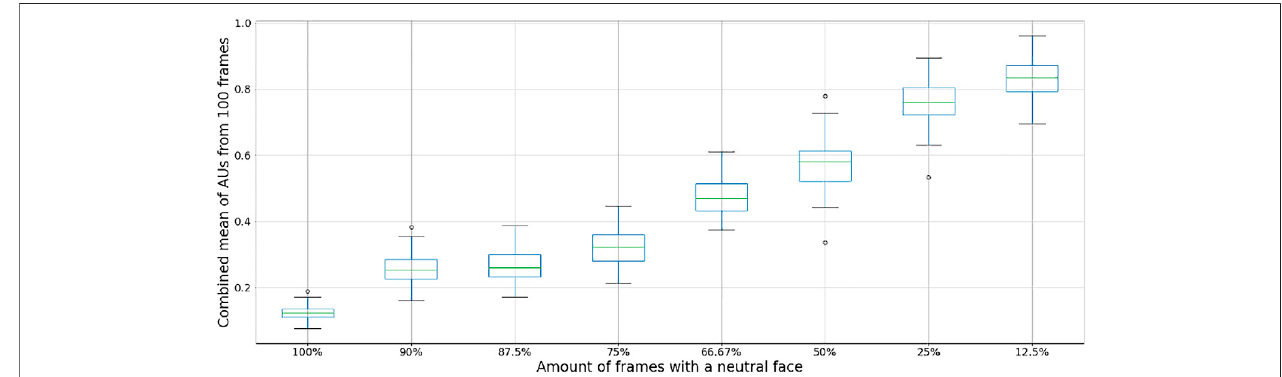
FIGURE 5 | Distribution of combined AU intensity values based on the frequency of a normal face analyzed with OpenFace 2.0.